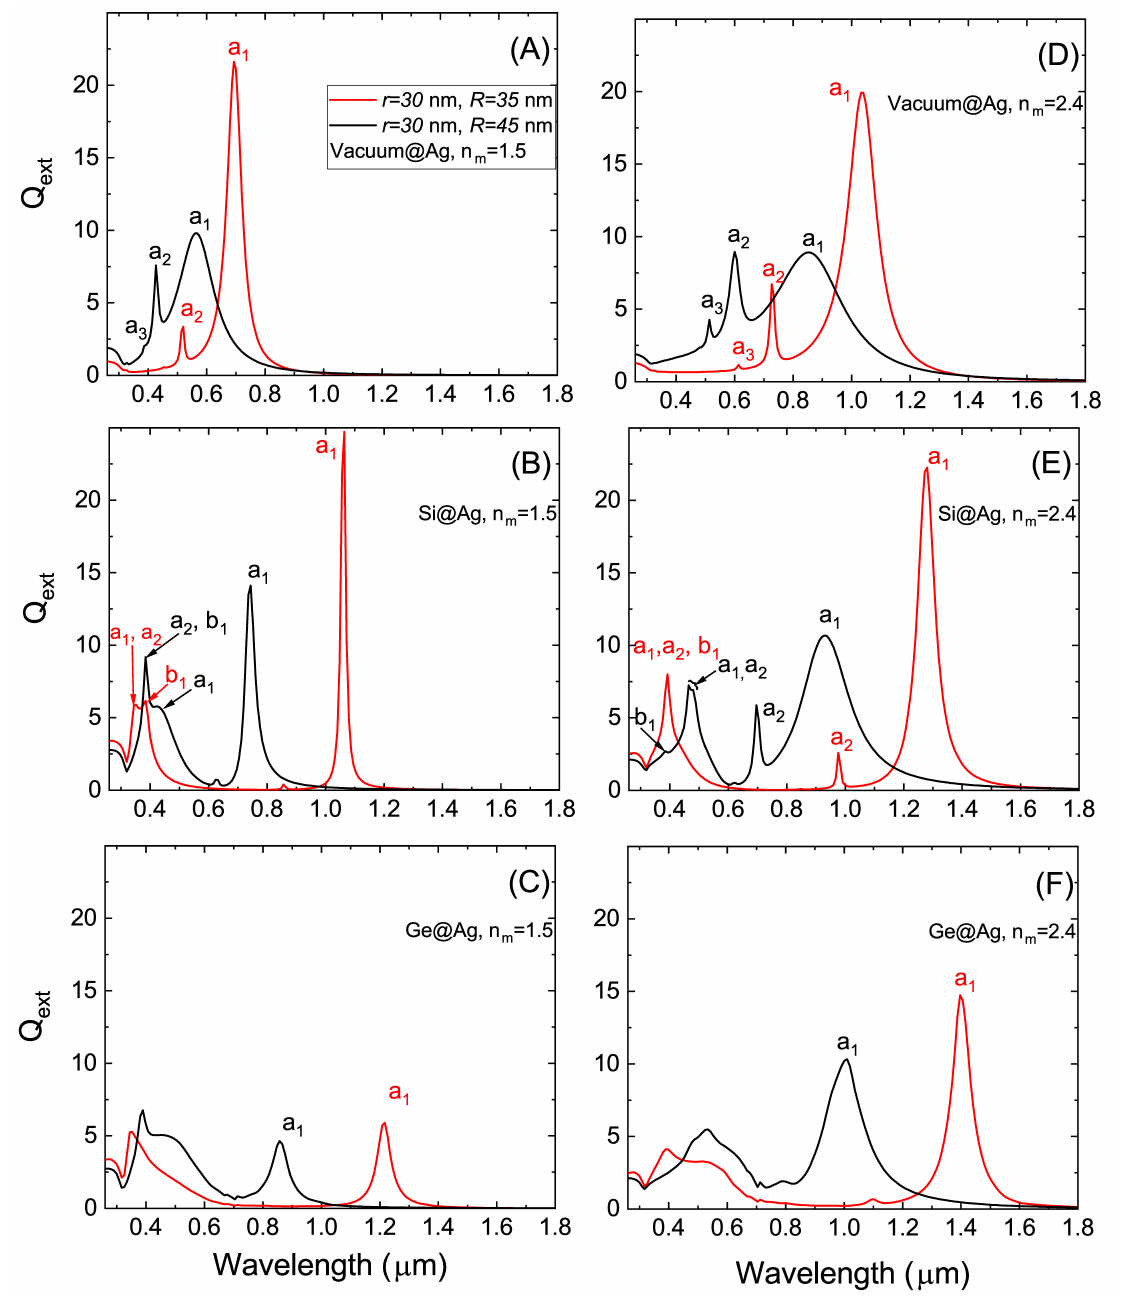
Figure 5. Q ext for particles with a core radius of r = 30 nm and having two specific dimensions R = 35 nm and R = 45 nm which are marked by dotted lines in Figure 4. The particles are embedded in a medium with a refractive index of ( A – C ) 1.5 or ( D – F ) 2.4. The core materials are ( A , D ) vacuum, ( B , E ) Si, and ( C , F )